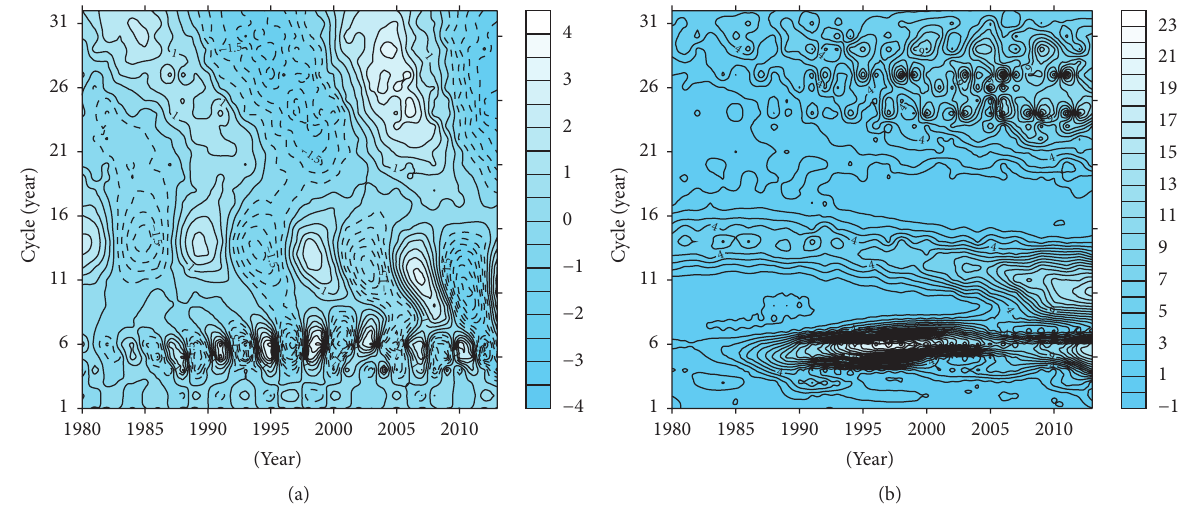
Figure 3: Theisolineof thereal partof wavelet coefficients, thenorm time-frequency ofwavelet coefficients of annual average air temperature.